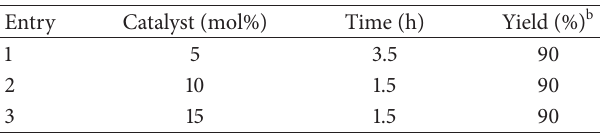
Table 2: Effect of amount of catalyst on the synthesis of N